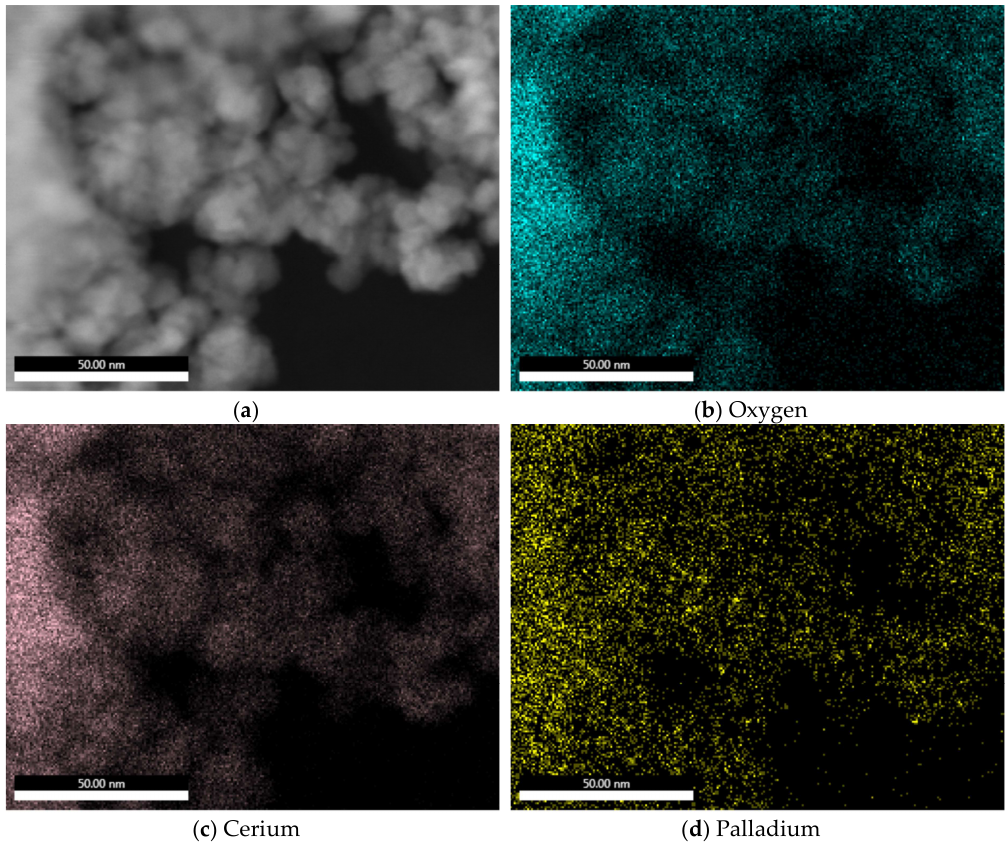
Figure 1. ( a ) SEM/EDS micro-image of Pd/CeO 2 ; element distribution maps of ( b ) oxygen (blue); ( c ) cerium (beige); and ( d ) palladium. Micro-images demonstrate homogeneously distributed Pd on the whole surface of CeO 2 for Pd/CeO 2 .